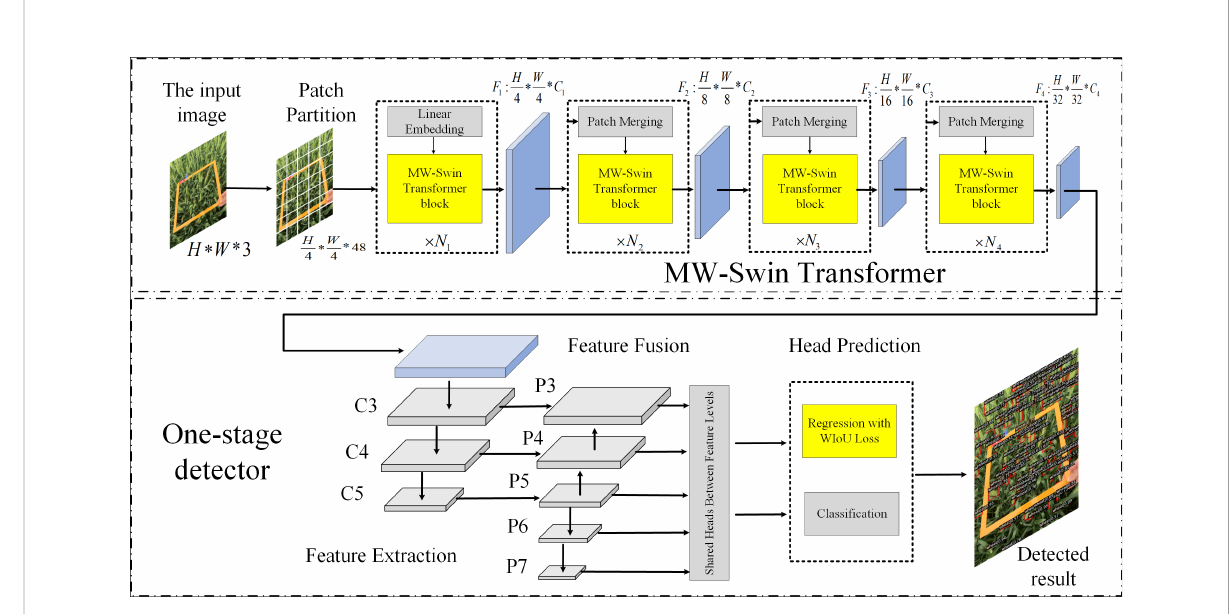
FIGURE 1 The main architecture of